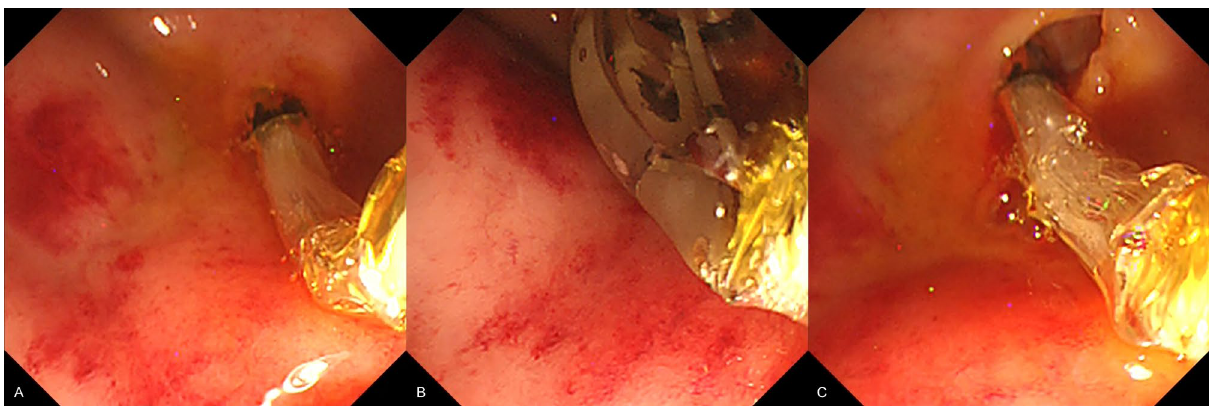
Figure 4. Endoscopic images of sphincteroplasty using the novel non-slip balloon the in vivo protocol. The band part of the balloon was positioned over the papilla ( A ), followed by balloon inflation. Although the lumen of the duodenum was narrow and distance could not be maintained from the papilla, the balloon was short and non-slippery, which enabled full expansion of the balloon without any slippage ( B ) with sufficient papillary dilation ( C